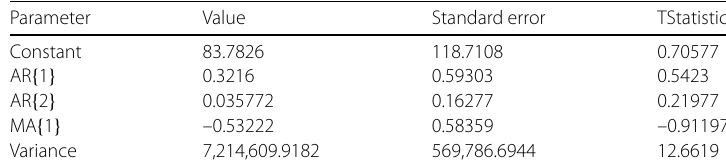
Table 3 Model estimation for the infected in Europe Parameter Value Standard error TStatistic